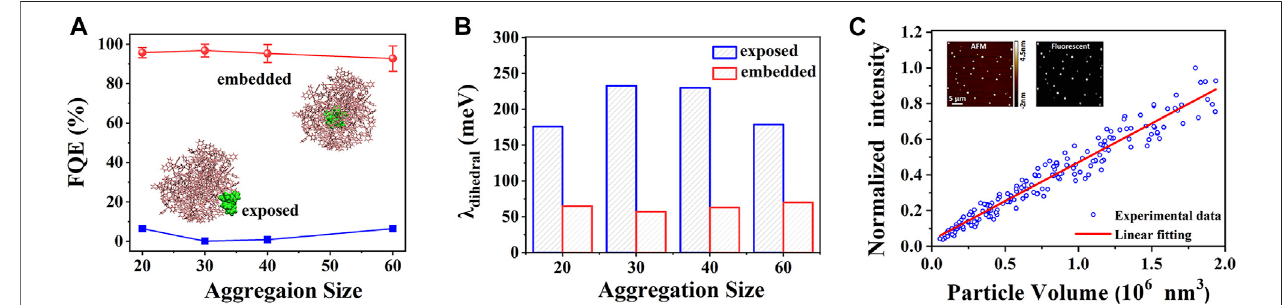
FIGURE2|(A) Average fl uorescence quantum ef fi ciency (FQE)offourembedded (red) andexposed(blue) HPS molecules extracted from amorphous aggregates with different sizes, and the representative embedded and exposed QM/MM models of HPS are shown in the insets. (B) λ dihedral of embedded and exposed HPS molecules in different sizes of aggregates. (C) Fluorescent intensity is linear to the volume of HPS aggregates. The volume (inset, atomic force microscope (AFM) image) and fl uorescence (inset, fl uorescence image) of individual HPS aggregate measured by fl uorescence confocal atomic force microscopy. The red solid line is the linear fi tting of experimental data (Jiang et al., 2017). (Reproduced with permission from Zheng et al. (2016); Copyright 2016 The Royal Society of Chemistry).